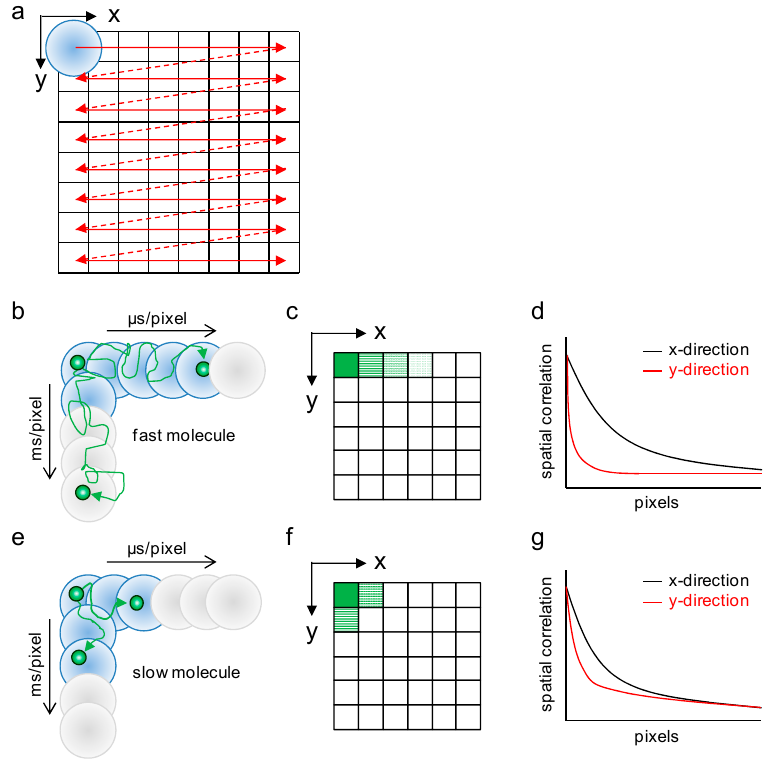
Figure 1. The principle of laser scanning microscopy (LSM) imaging for raster image correlation spectroscopy (RICS) analysis. ( a ) LSM images consist of pixels from line-by-line scanning. The detectable fluorescent signal (blue circles) and undetectable cases (gray circle) of: ( b ) fast; and ( e ) slow moving molecules (green circles) from scans result in the LSM image (( c , f ), respectively). The spatial correlation of: ( d ) fast; and ( g ) slow moving molecules. Black and red lines represent the correlations calculated from the x - and y -direction pixels, respectively.